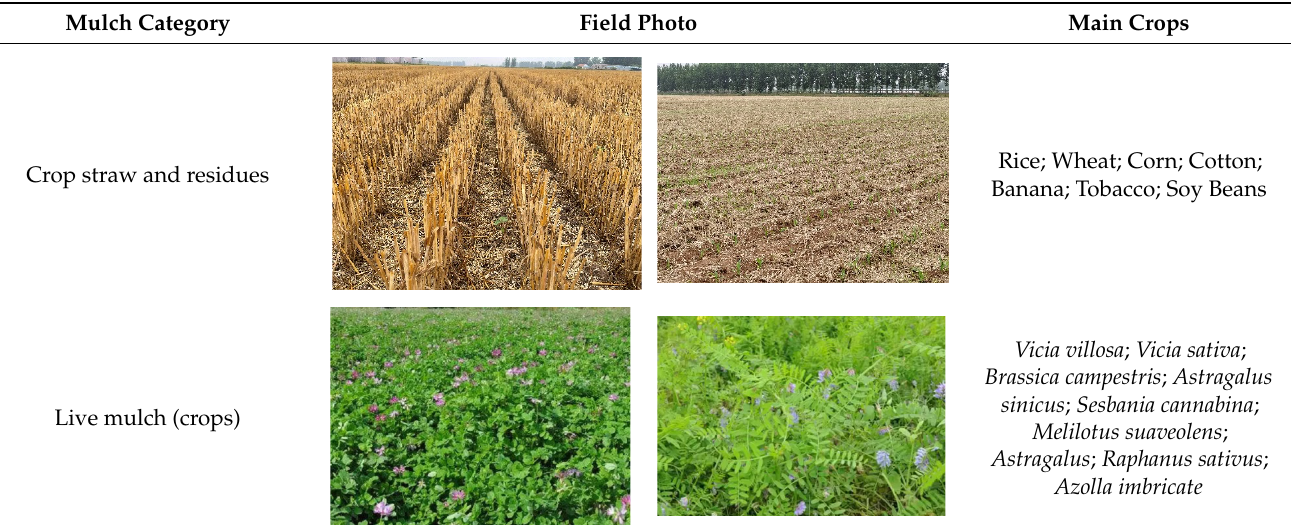
Table 1. Relevant development regulations of straw management technology in China.